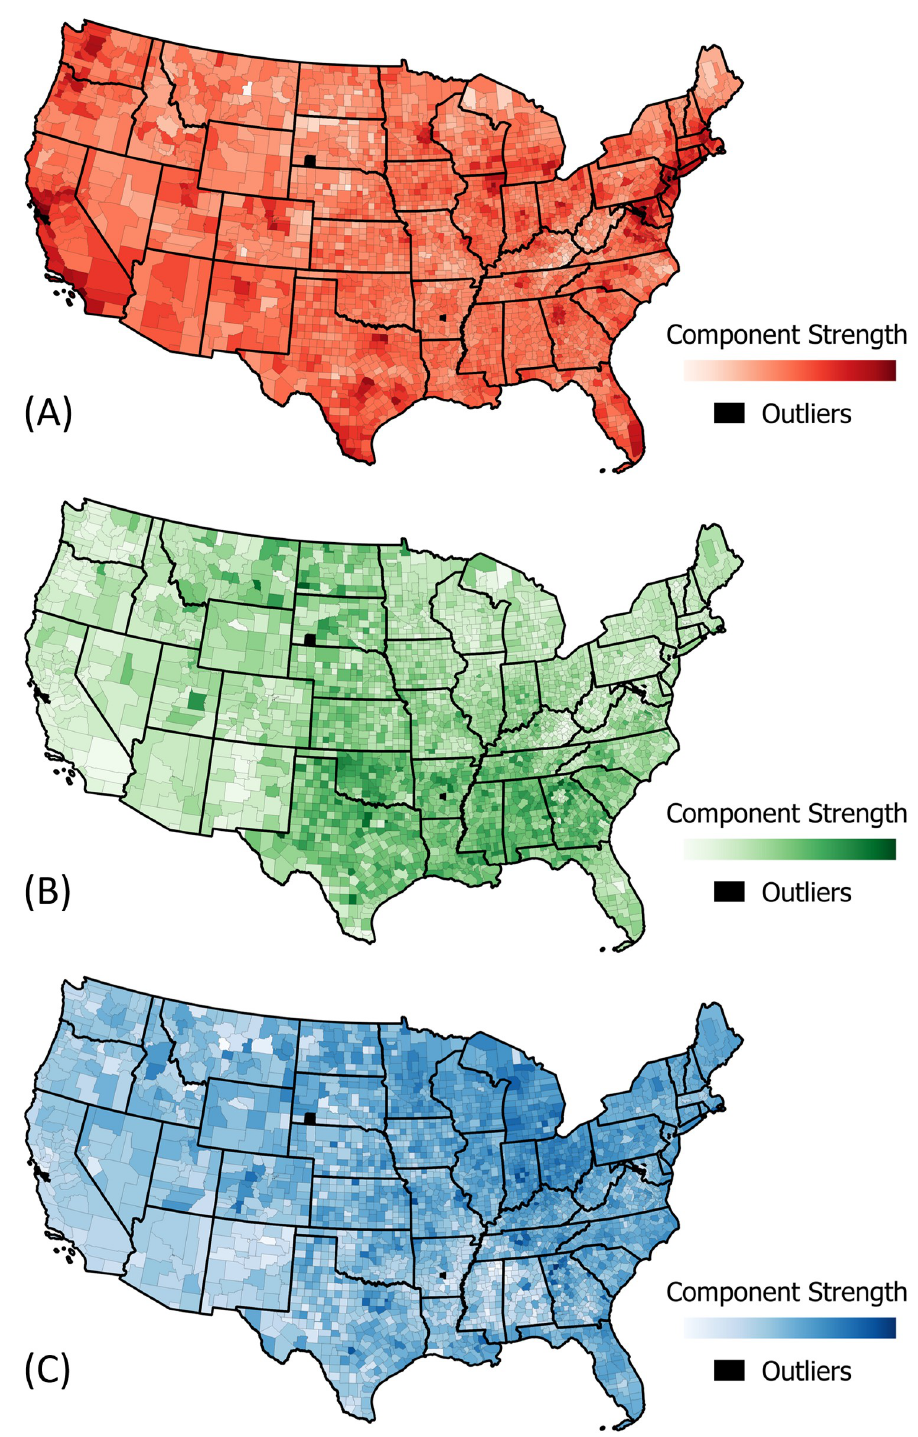
Fig 5. Spatial distribution of the three principal components of change of public exposure. (A) Principal Component 1: Reduced Δ TSPP March-December (B) Principal Component 2: Increased Δ TSPP March-December (C) Principal Component 3: Reduced Δ TSPP March-June. Maps produced in QGIS [30] using SafeGraph [3] derived data, shapefiles from data.gov [31].